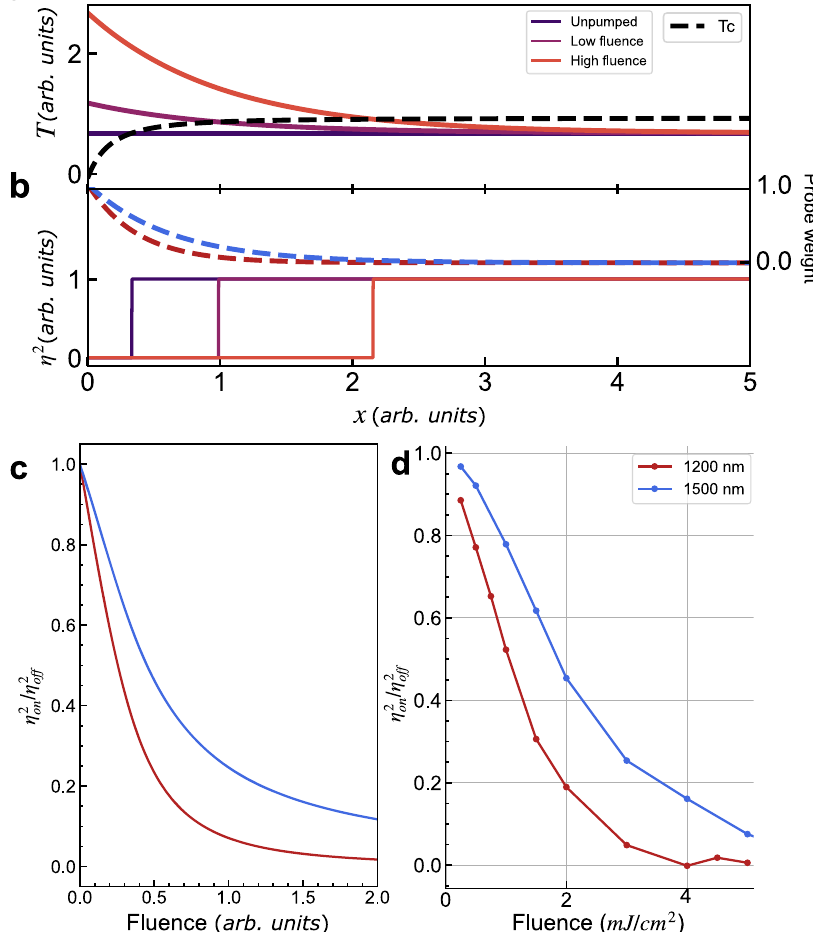
Fig. 5 Inhomogeneity in the photo induced phase transition. a First-order phase transitions can show surface melting, with the orbital of the phase transition melting at a lower transition temperature than the bulk. The black dashed line shows the thermodynamic transition temperature as a function of position in the sample from the surface at x = 0, together with two pump-induced temperature pro fi les. b The effect of the pump on the spatial dependence of the order parameter. Due to surface melting, part of the sample is already melted before the pump, resulting in a phase front. This phase front moves deeper into the bulk for harder excitation. The dashed lines indicate the weighting of the local order parameter on the averaged order parameter measured by probes which penetrate two different depths. c The measured order parameter as a function of pump fl uence for two different probe conditions. Probes that penetrate less into the bulk reach saturation at a lower fl uence than those that penetrate deeper. d Experimental data showing that changing the probe wavelength to 1200 nm reaches saturation before 1500 nm, demonstrating the role of spatial inhomogeneity in the